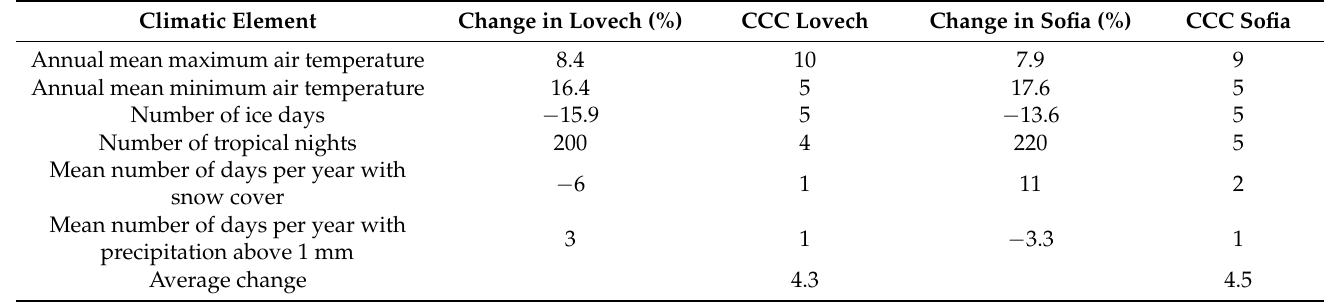
Table 1. CCC of selected climatic elements between the periods 1961–1990 and 1989–2018. Climatic